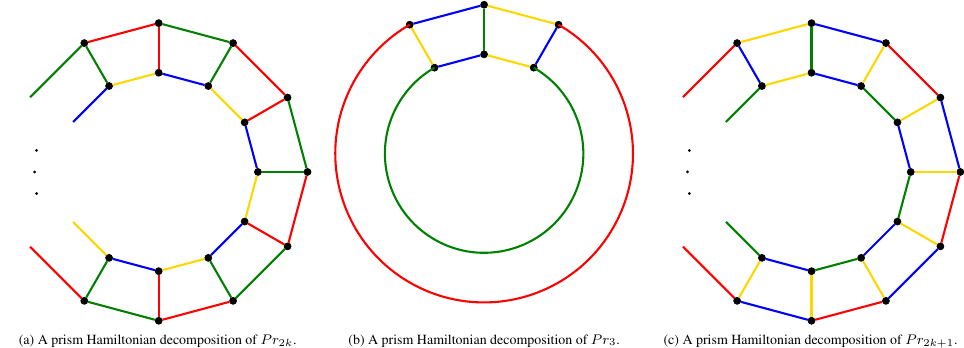
Fig. 8: The prisms are prism-decomposable.